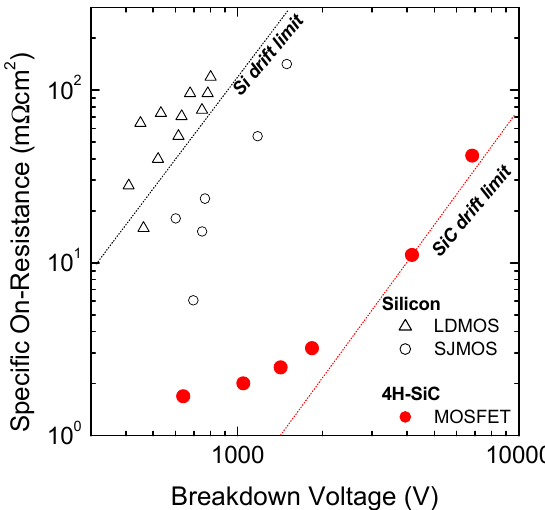
Figure 1. Comparison of R on,sp as a function of the breakdown voltage (BV) for Si and 4H-SiC power metal oxide semiconductor field effect transistors (MOSFETs). The solid lines are the theoretical unipolar limit. The experimental data are taken from Reference [2].